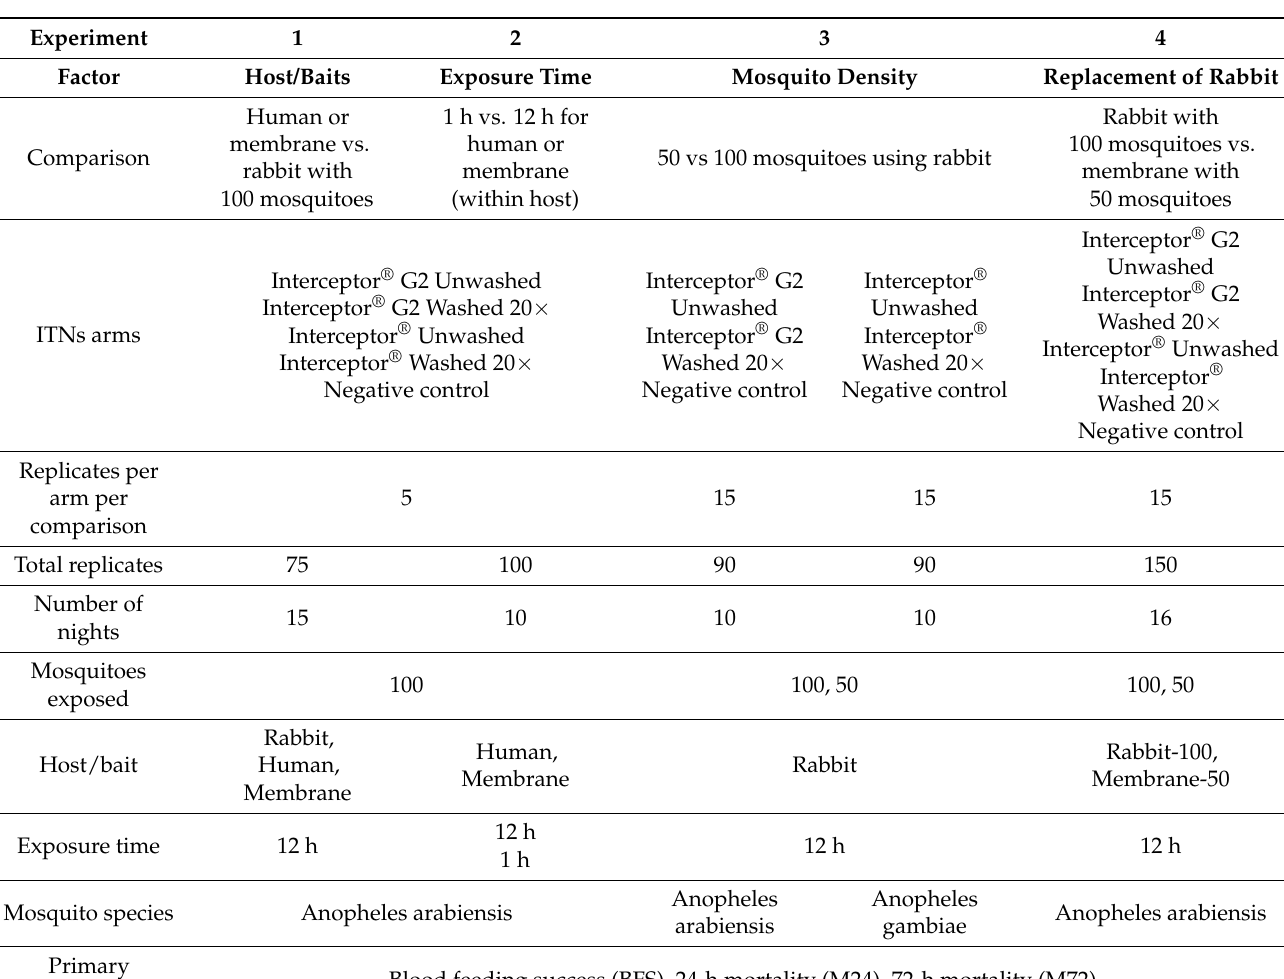
Table 1. Experimental